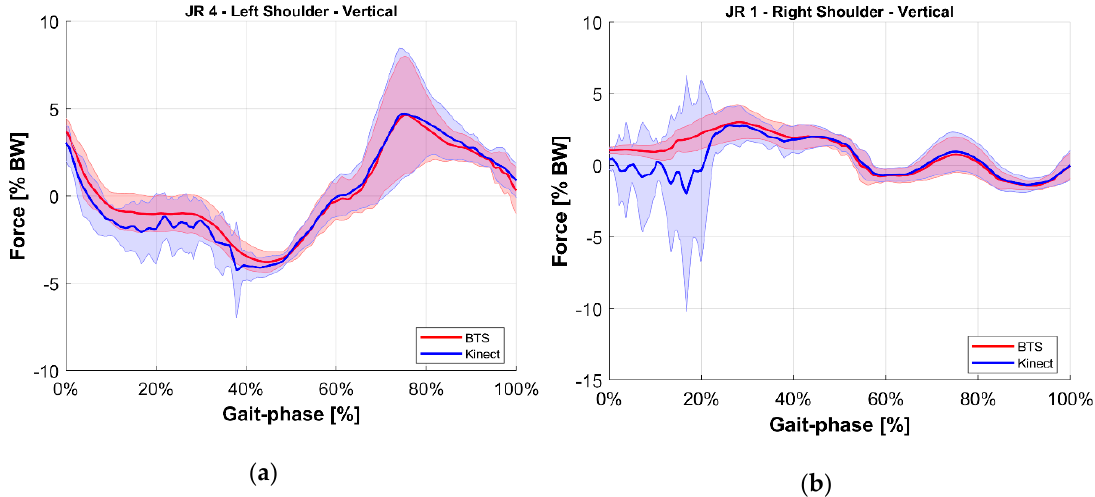
Figure 11. Vertical internal reaction force at the shoulder joint. Blue indicates the M-Kinect assessment. Red indicates the reference using BTS marker-based mocap. Bold lines represent the average of all tests. The shaded areas represent their standard deviation. ( a ) Left joint. ( b ) Right joint. The subject was right-dominant.